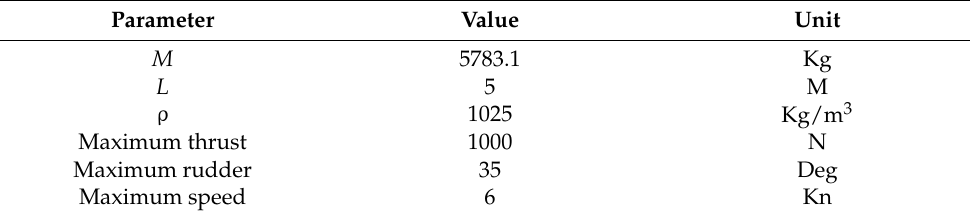
Table 1. The main parameters of AUV model.